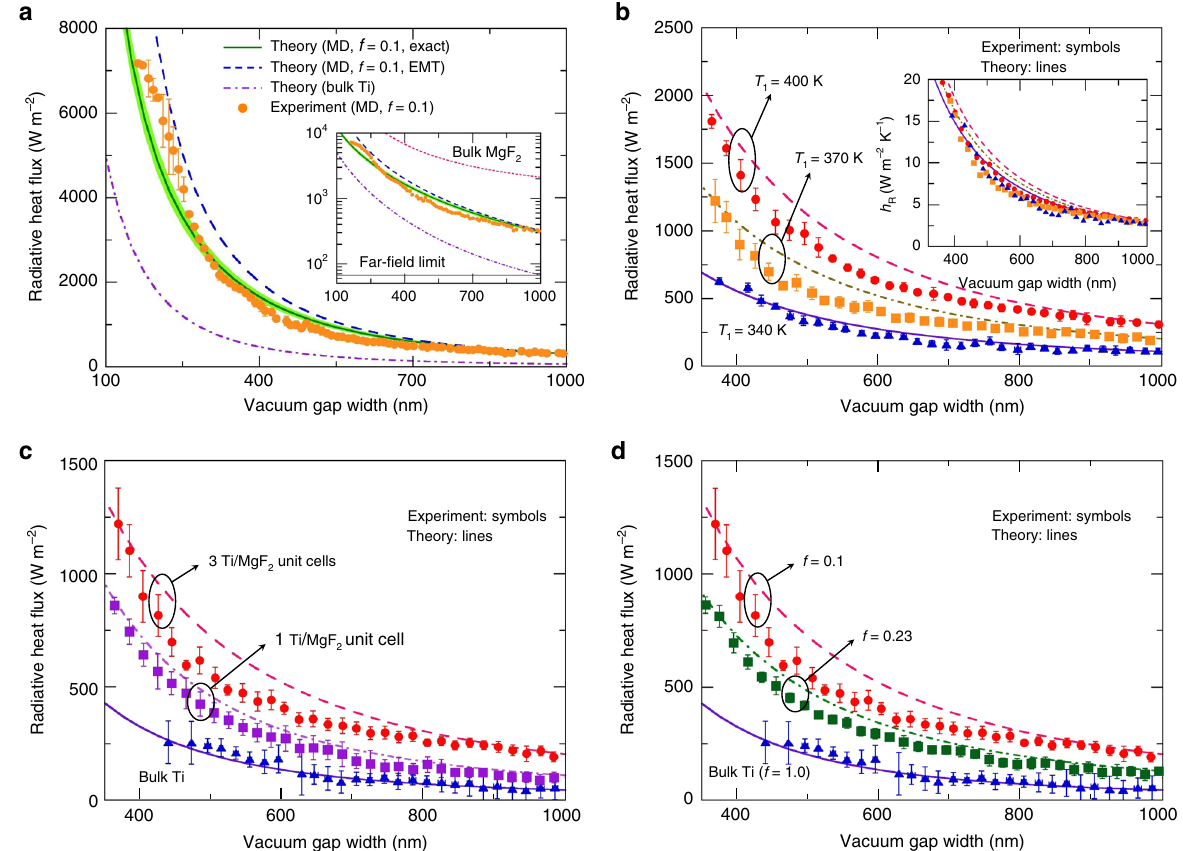
Fig. 4 Manipulation of near- fi eld radiation by modifying surface condition with MD multilayers. a Measured near- fi eld radiative heat fl ux between MD multilayers ( f = 0.1, 3 Ti/MgF 2 unit cells) with respect to the submicron vacuum gap distance (emitter temperature: 400 K and receiver temperature: 300 K). Theoretical results of near- fi eld thermal radiative heat fl ux between multilayered structures that are computed considering multiple re fl ections in multilayer (i.e., exact computation) or effective medium theory (EMT), as well as between bulk Ti media, are plotted. The inset shows the near- fi eld radiative heat fl ux plotted on log scale. Calculated near- fi eld radiative heat fl ux between bulk MgF 2 media and far- fi eld radiative heat fl ux between Ti/MgF 2 multilayers are also plotted. b Near- fi eld radiative heat fl ux between MD multilayers ( f = 0.1, 3 Ti/MgF 2 unit cells) as a function of emitter temperature. The inset is a graph of radiative heat transfer coef fi cient h R for all measured data. c Enhanced near- fi eld radiative heat fl ux between MD multilayers ( f = 0.1) with different numbers of unit cells. Emitter temperature is set to 370 K. d Tuning of near- fi eld radiative heat fl ux by changing of volume fi lling ratio of MD multilayer, f (3 Ti/MgF 2 unit cells). The near- fi eld radiative heat fl ux is measured at an emitter temperature of 370 K. The error bars in a – d represent the combination of the measurement uncertainty and standard deviation of multiple measurements (Supplementary Note